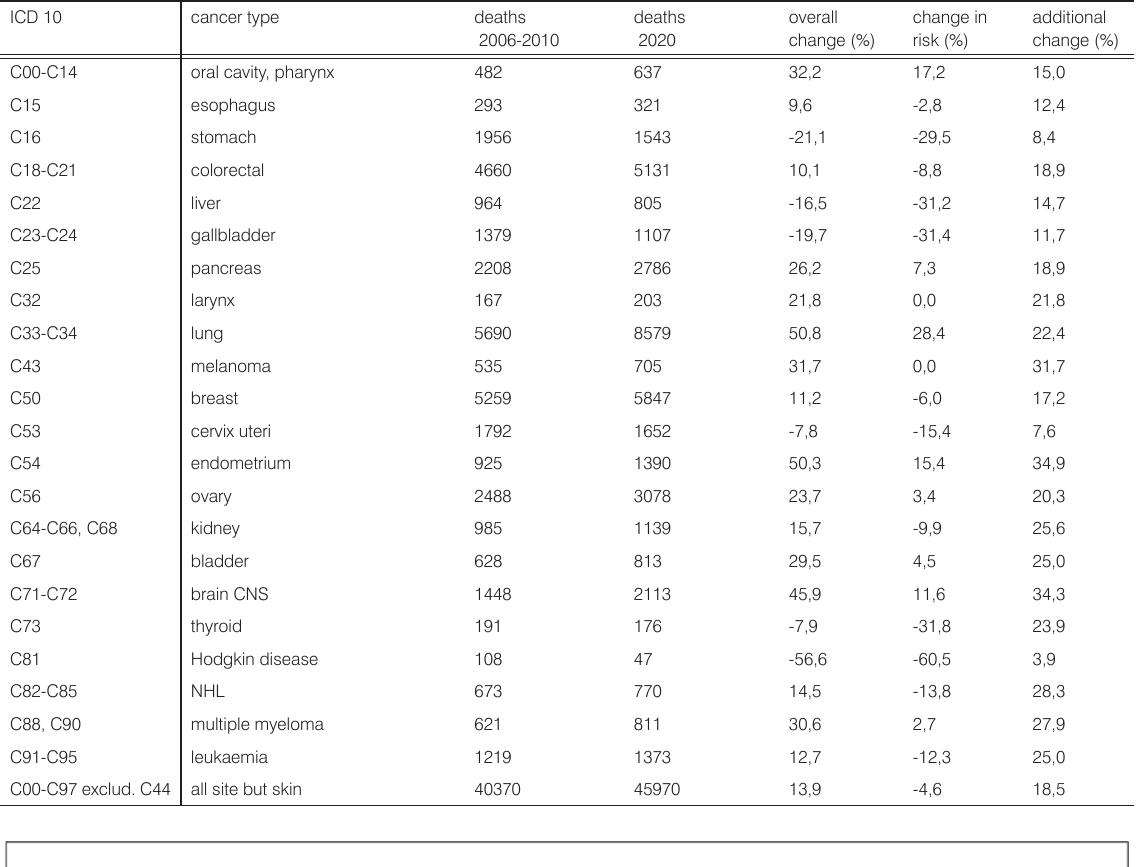
Table 2. Mean annual number of cancer deaths as observed in 2006-2010 in Poland and predicted for 2020 by site, females. Corresponding percentage change in mortality, decomposed into changing risk and additional change.